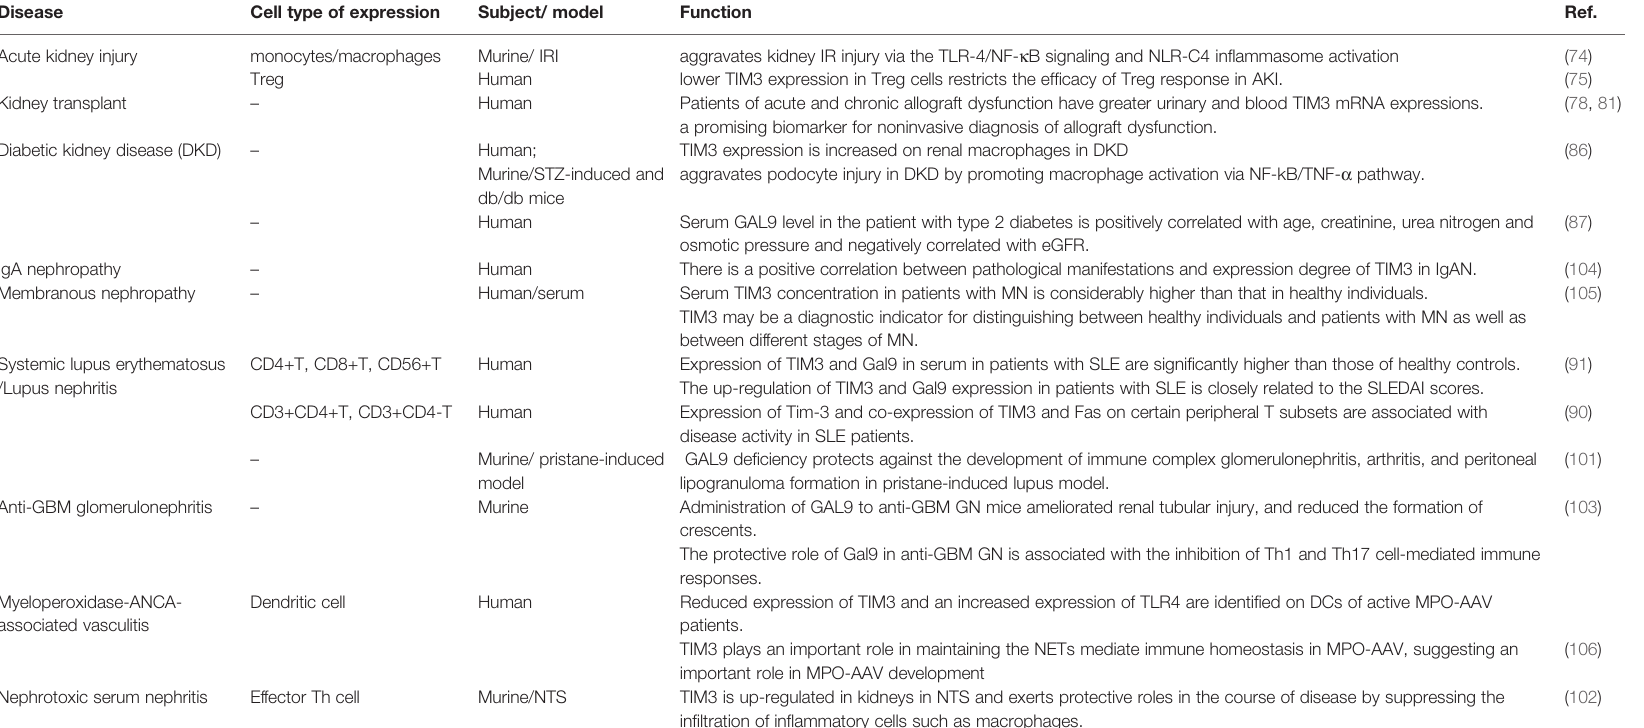
TABLE 2 | The role of TIM3 in kidney diseases.